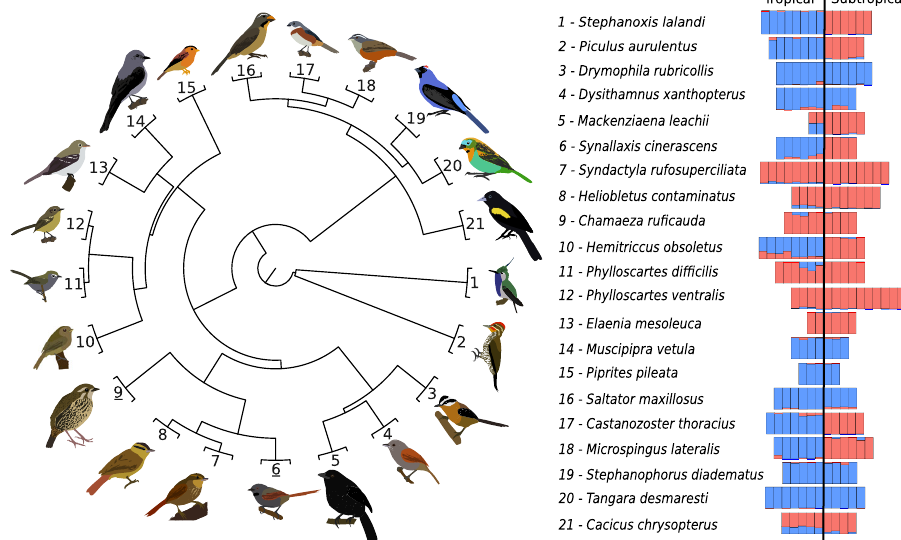
Fig. 2 Phylogenetic relationship and genetic structure of the focal species of birds that occur in the Atlantic Forest Sky islands (left). Phylogeny was estimated by ref. 57 . Each terminal was duplicated to represent the tropical and subtropical populations of each species. Bar plots (right) show the genetic structure within each species, where each bar is one individual, and colors represent assigned ancestral populations. Values were estimated using a spatial explicit algorithm that controls for the effects of isolation-by-distance (see Material and